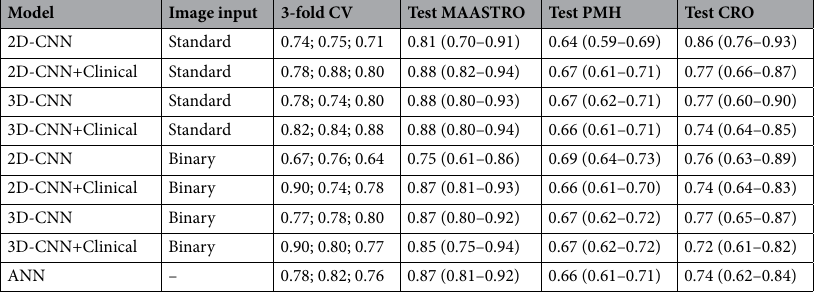
Table 2. Comparison of HCIs for CV and testing for different time-to-event models and the two different image input scenarios. The numbers shown for the 3-fold CV are HCIs obtained for the CV subsets. Numbers for the testing sets represent the median HCI and in brackets the 83% confidence intervals obtained via bootstrap re-sampling. Note that HCIs for the ANN are shown only once because the only input are clinical variables of the corresponding